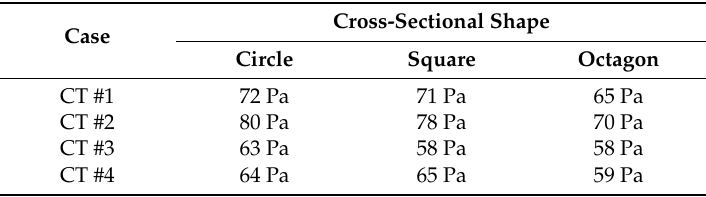
Table 4. Estimated pressure drops on components of investigated closed-loop wind tunnel (V ex = 60 m/s).